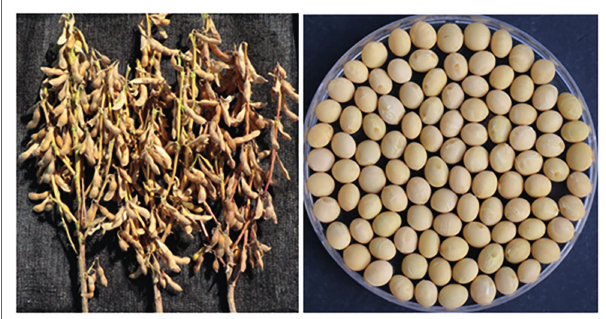
FIGURE 5 | Appearance of F 5 plants and F 6 seeds possessing penta null alleles ( lox1lox2lox3 / lox1lox2lox3 - ti / ti - le / le - cgy1 / cgy1-rs2/rs2